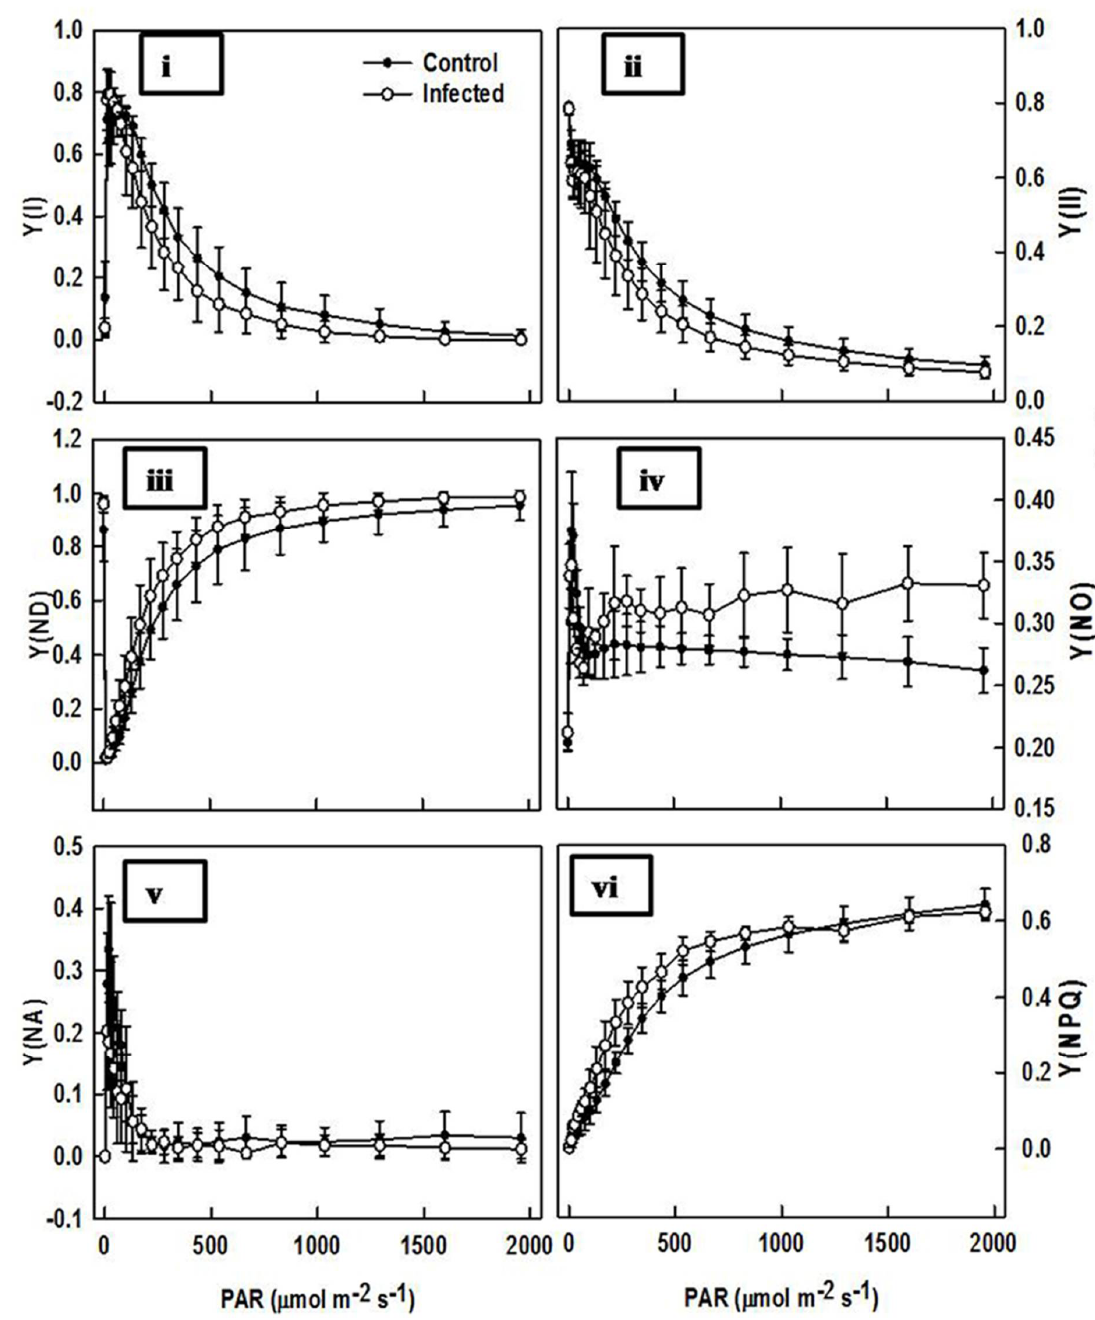
Figure 7. Light response of PSI and PSII in control (healthy) (-●-) and leaf curl-infected (-o-) leaves. ( i ) Y(I): Photochemical quantum yield of PSI. ( ii ) Y(II): Effective quantum yield of PSII. ( iii ) Y(ND): Quantum yield of non-photochemical energy dissipation due to donor side limitation. ( iv ) Y(NO): Quantum yield of non-regulated energy dissipation in PSII. ( v ) Y(NA): Quantum yield of non- photochemical energy dissipation due to acceptor side limitation. ( vi ) Y (NPQ): Quantum yield of regulated energy dissipation in PSII.